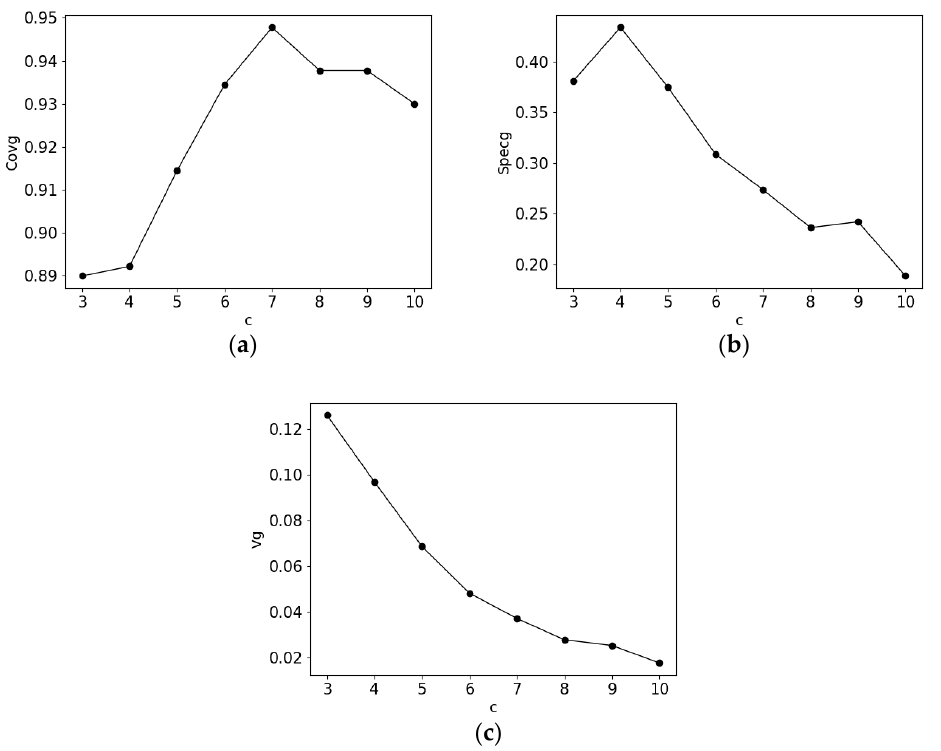
Figure 8. The curves of Cov g , Spec g , and V g under different c values. ( a ) Cov g curve ( b ) Spec g curve ( c ) V g curve.